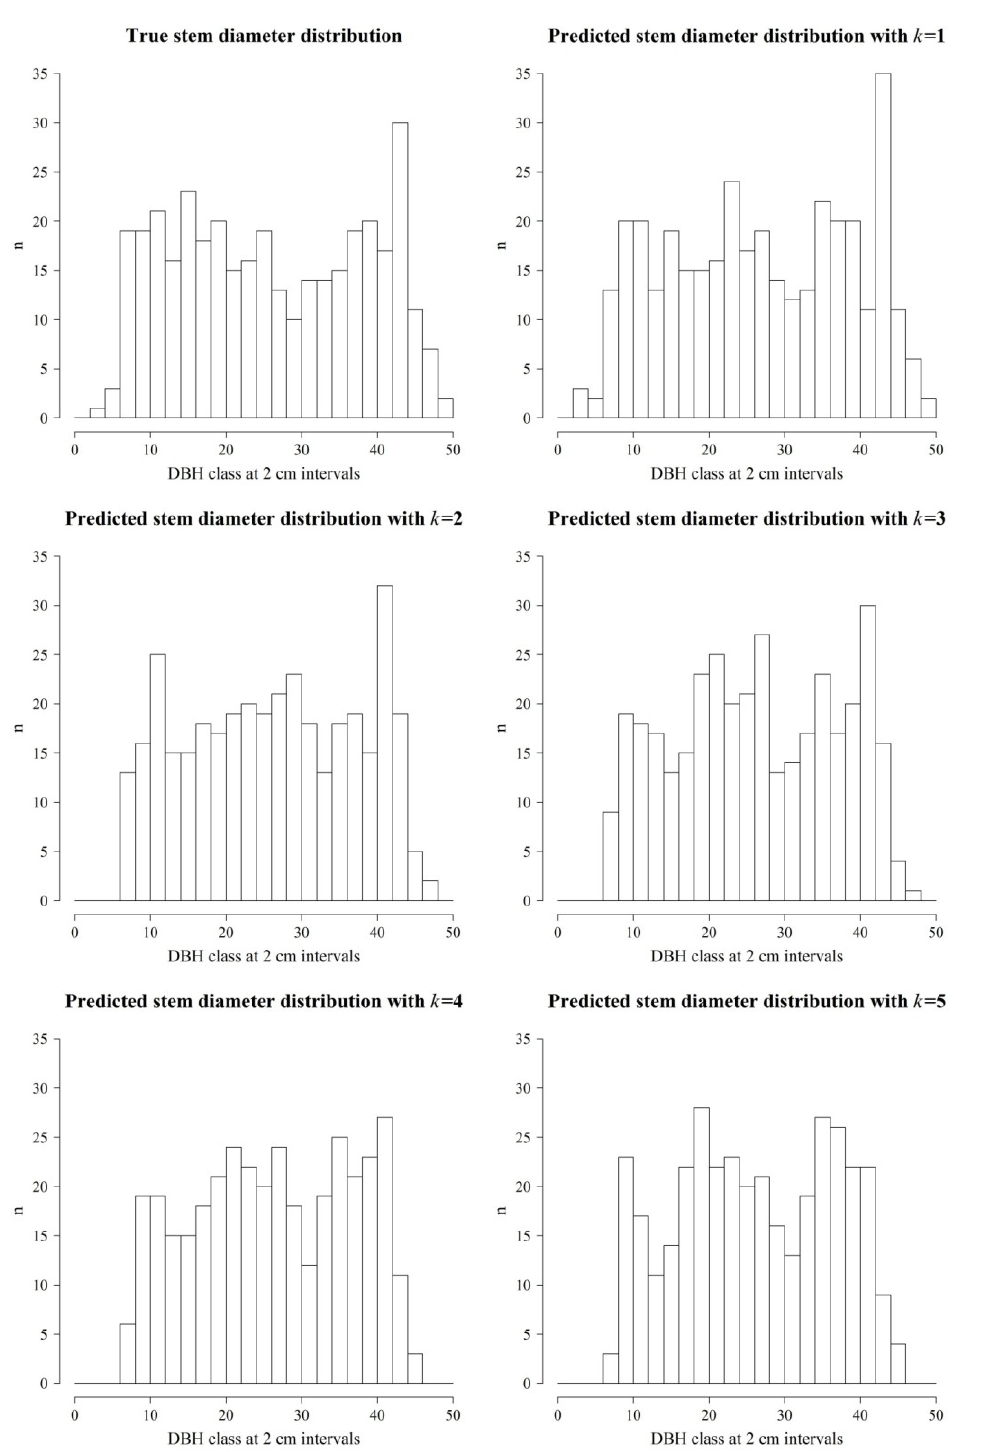
Figure 6. True stem-diameter distribution ( top left ) and predicted stem-diameter distributions with different k values for the forested southern part of the study